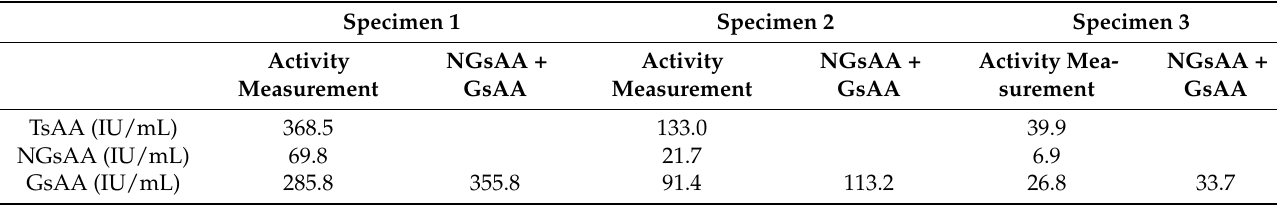
Table 4. Activity results of salivary alpha-amylase (sAA) in three saliva specimens with different activities measured before the depletion treatment (Total sAA, TsAA), in the first supernatant obtained after the depletion treatment corresponding to the non-glycosylated sAA (NGsAA) proteoform, and in the second supernatant obtained after adding 1M methyl mannopyranoside (MMp) at 1:100 sample dilution corresponding to the glycosylated sAA (GsAA) proteoform.